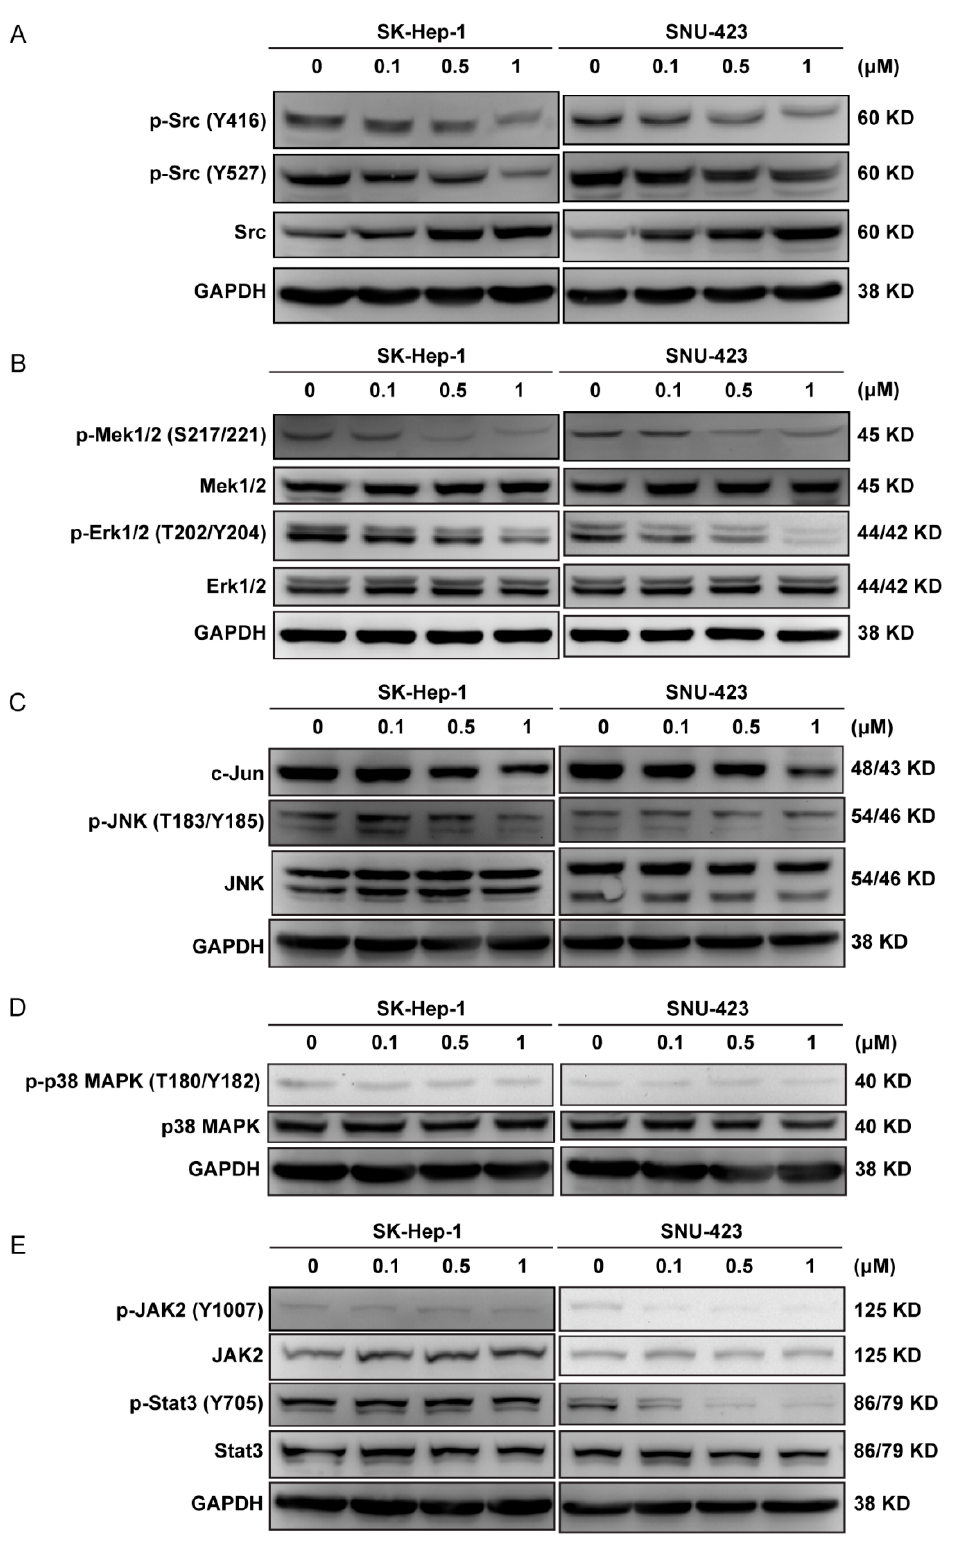
Figure 4. Effect of ponatinib on the phosphorylation of signaling proteins. ( A ) Effect of ponatinib on the phosphorylation of Src on Tyr416 and Tyr527. ( B – E ) Effect of ponatinib on the phosphorylation of Mek, Erk, JNK, c-Jun, p38, Jak2, and Stat3. Glyceraldehyde-3-phosphate dehydrogenase (GAPDH) was used as a control.